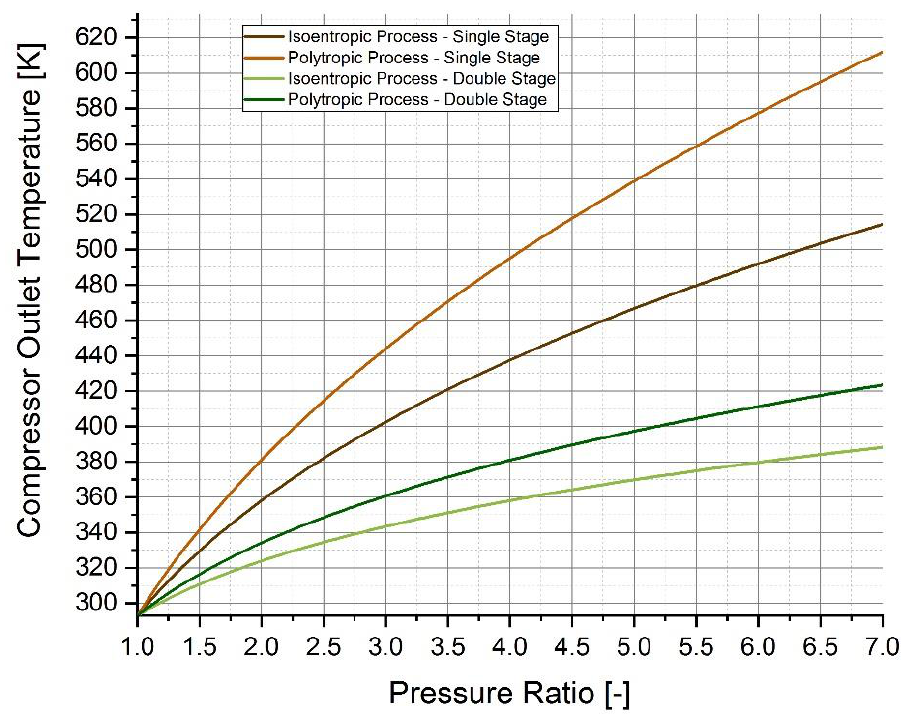
Figure 7. Hydrogen density levels as a function of pressure and temperature.